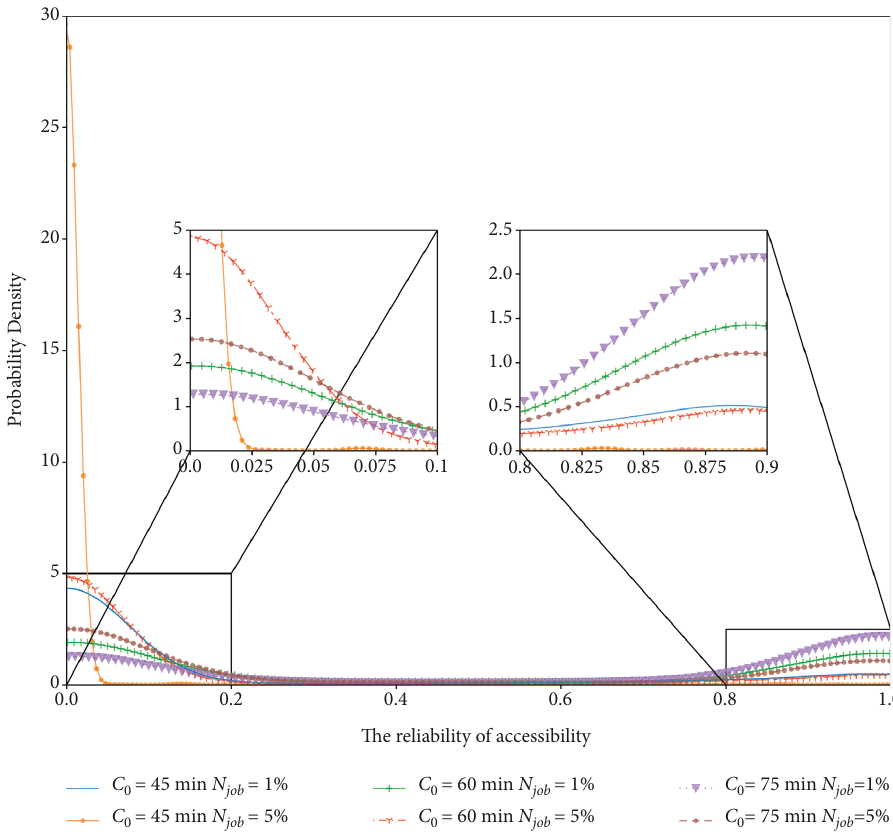
Figure 5: Probability density curves of the reliability of